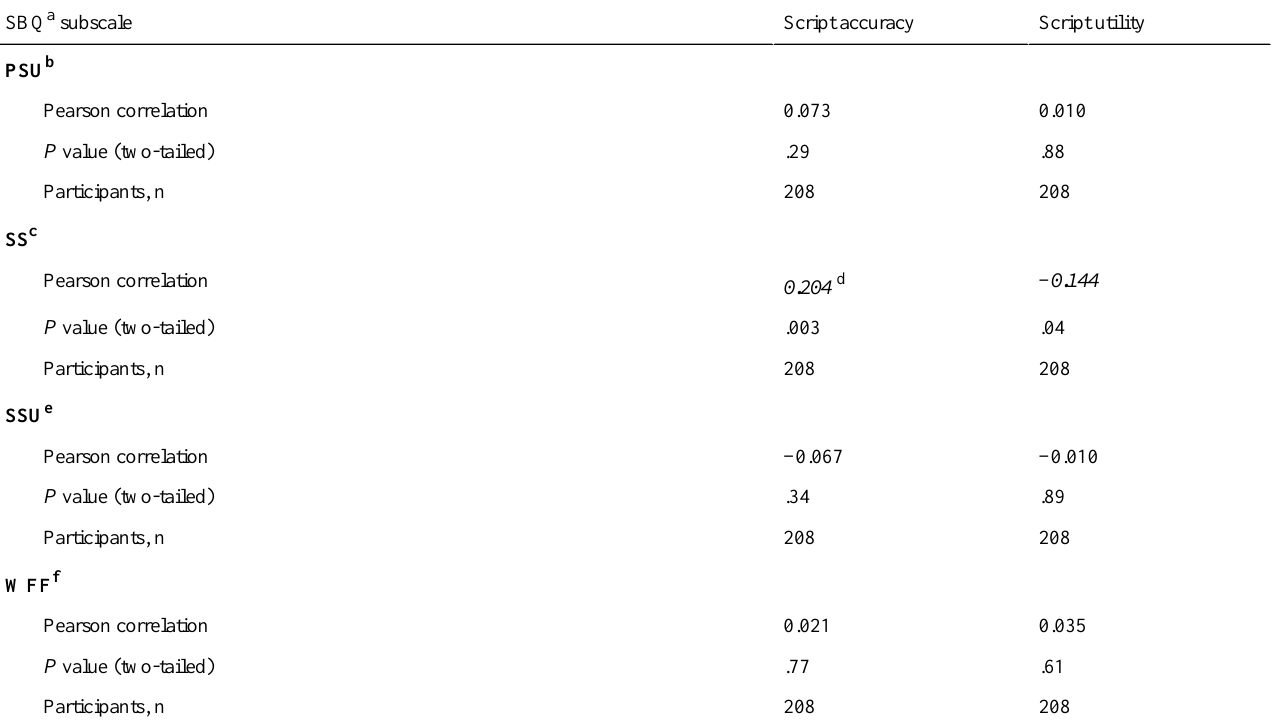
Table 5. Significant Other Behavior Questionnaire subscale and overall script accuracy and utility ratings.